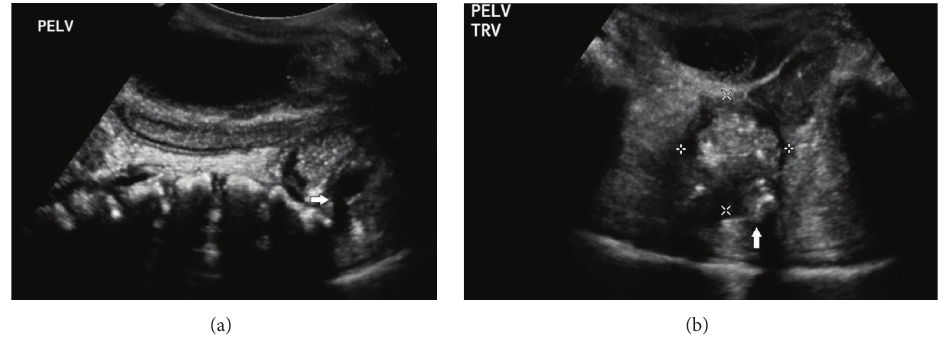
Figure 6: Abdominal ultrasound on day 7 to evaluate the neuroenteric fistula. (a) Gray scale sagittal image demonstrates a complex presacral mass with heterogeneous echogenicity and multiple echogenic foci representing air. There is a hypoechoic cystic structure within it which is in continuity with the sacral canal (arrow). (b) Subsequent transverse gray scale US image shows echogenic foci representing air in the small inferior hypoechoic cyst with the presacral mass (within calipers) suggesting continuous fistulous connection